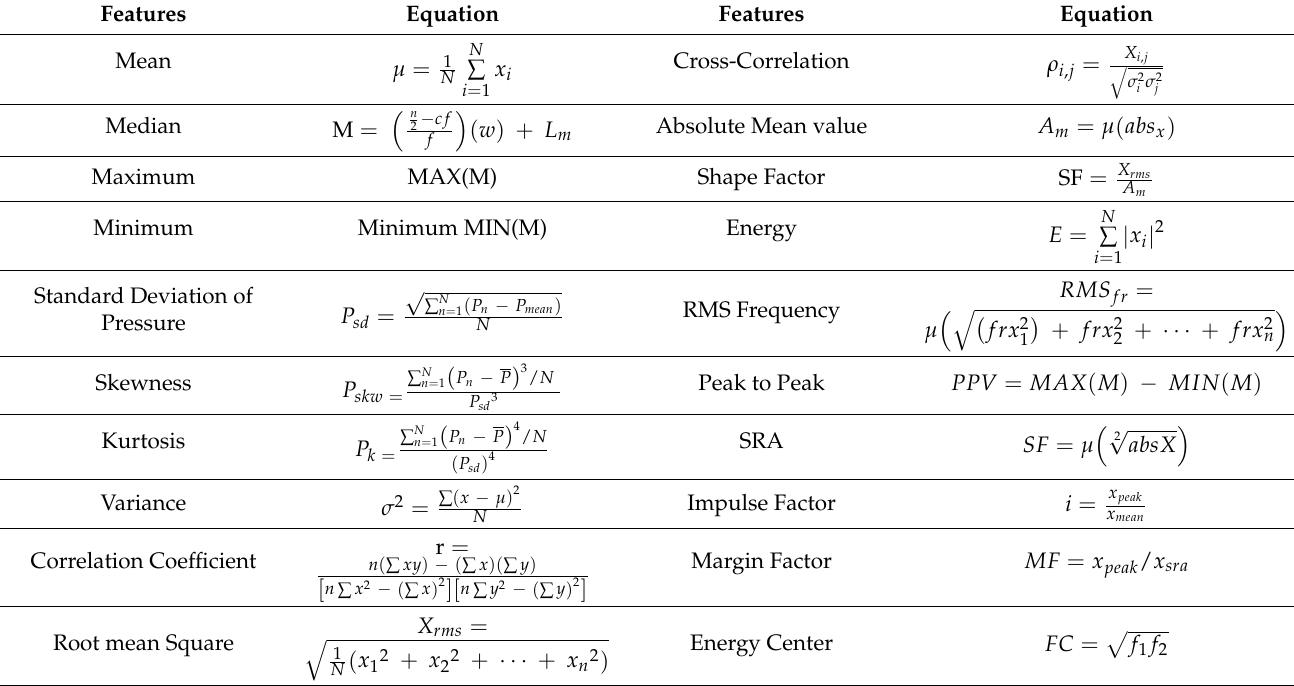
Table 2. Statistical Features from Pen-Tablet Sensor